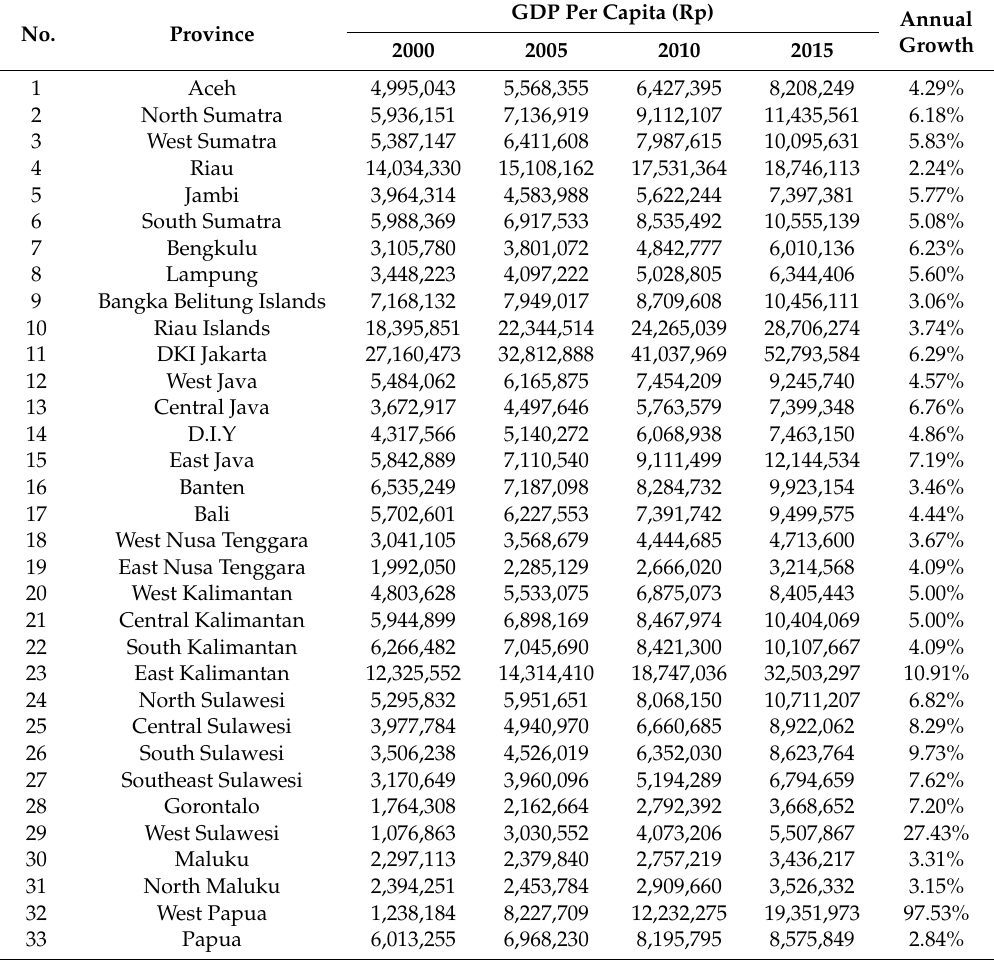
Table 4. GDP per capita of provinces, 2000–2015